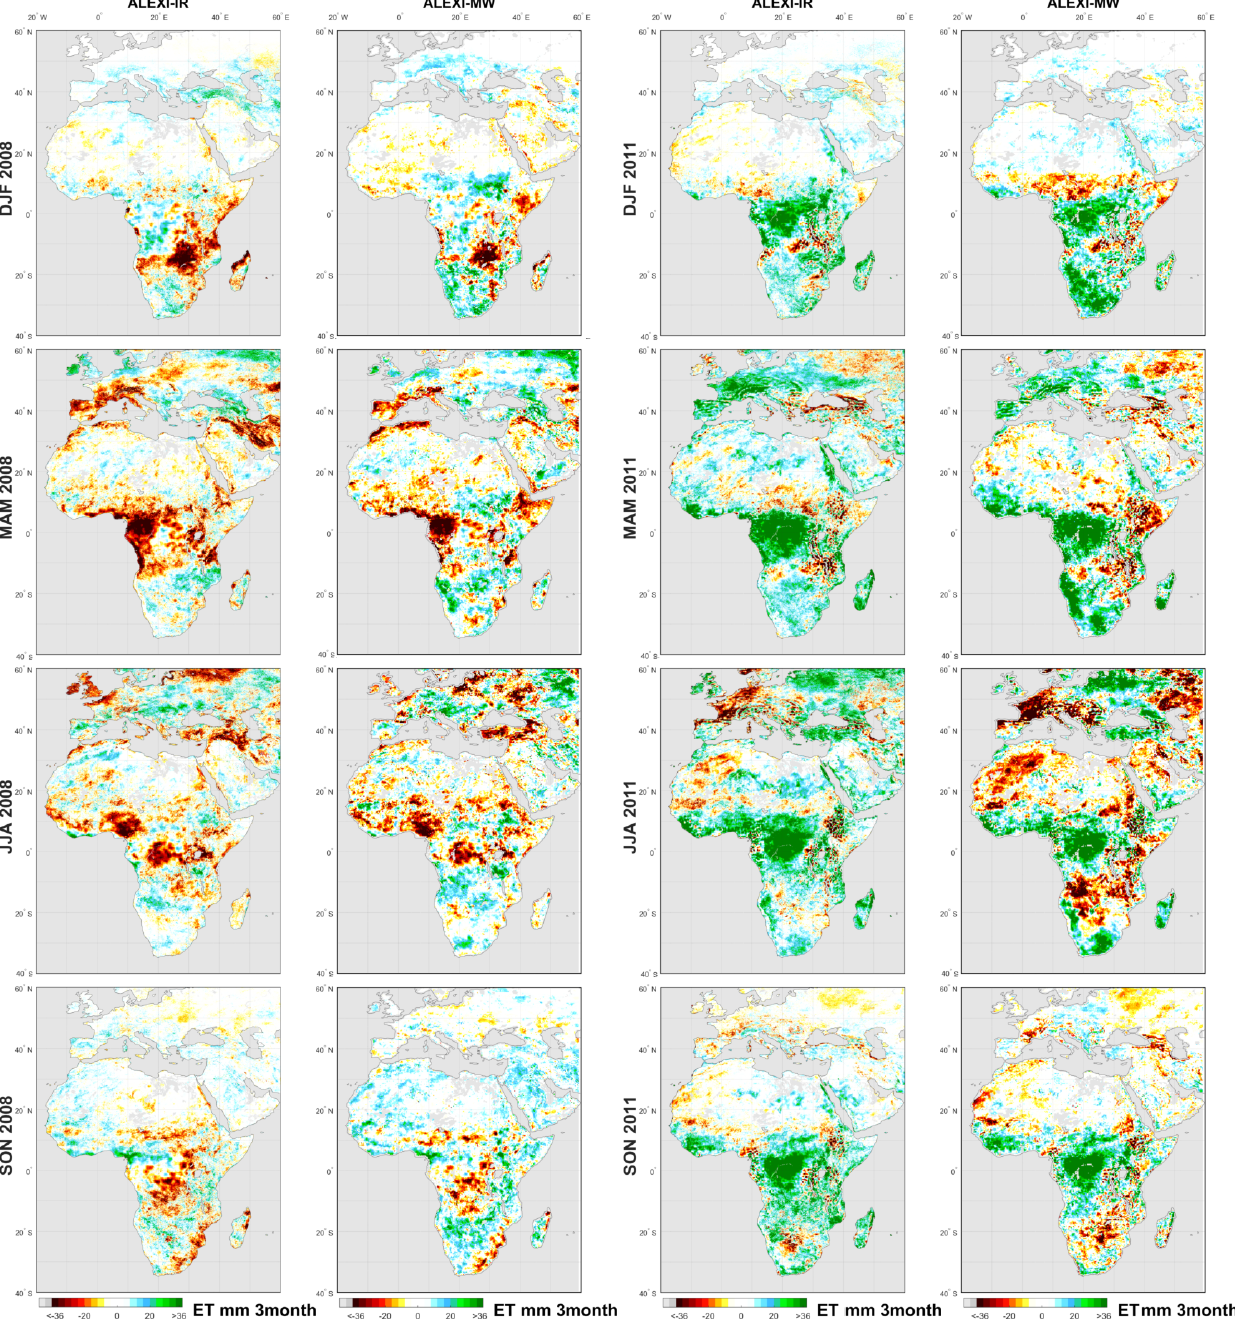
Figure 9. Anomaly in seasonal ET compared to multi-year mean (2003–2011, see Fig. 6) as retrieved by ALEXI-IR and ALEXI-MW. The first two columns show the anomalies for 2008 and the two right-hand columns show them for